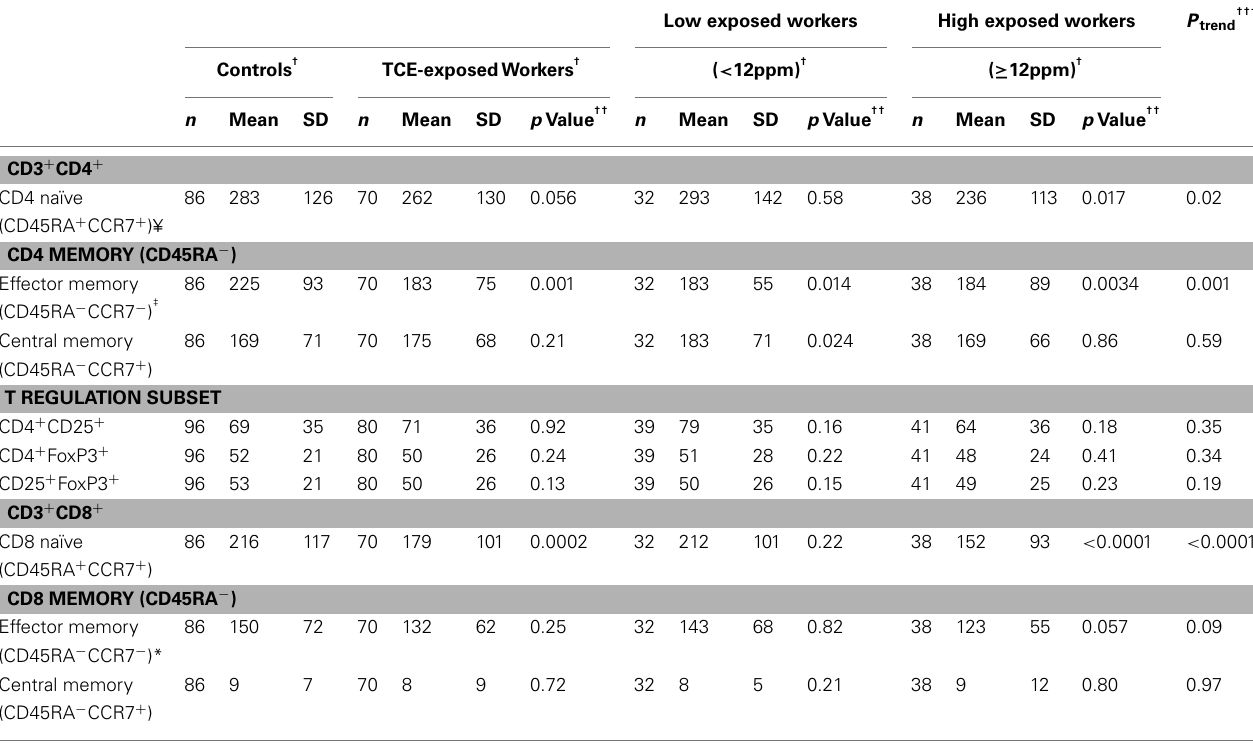
Table 2 |T cell subset counts mean ± SD among trichloroethylene (TCE) exposed workers and unexposed controls. Low exposed workers High exposed workers